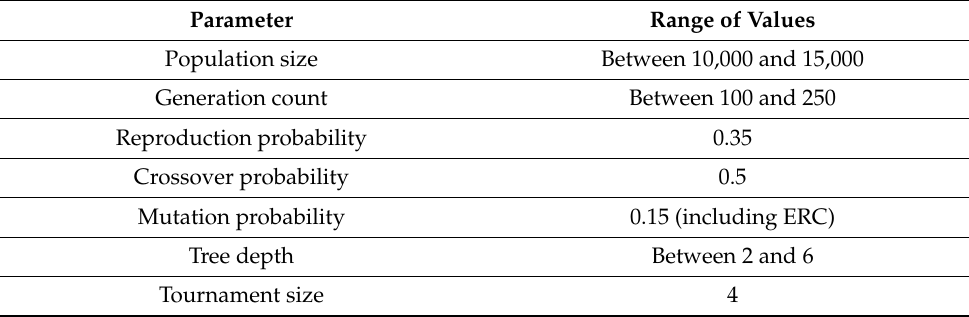
Table 1. Parameters for the GP algorithm.